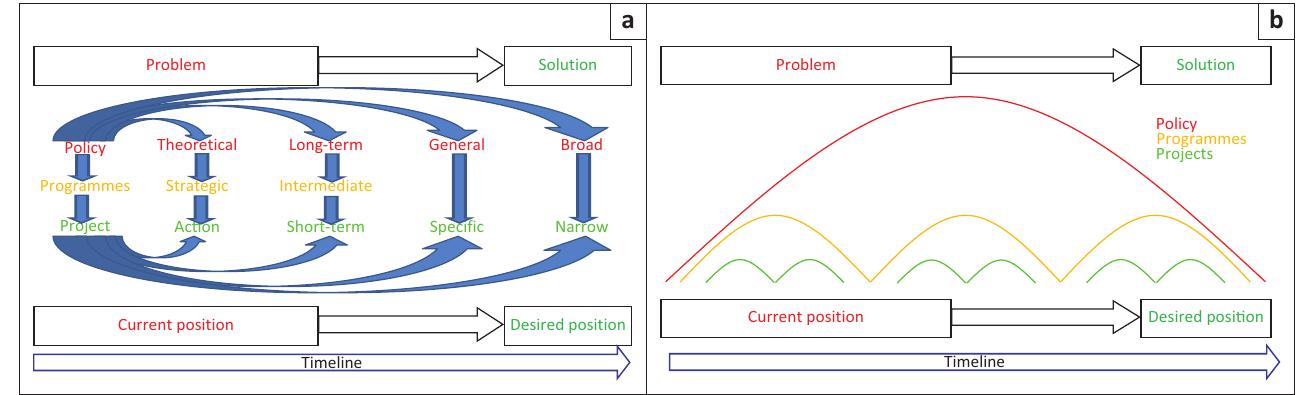
FIGURE 4: Illustrating the three levels of development interventions and their distinguishing attributes and